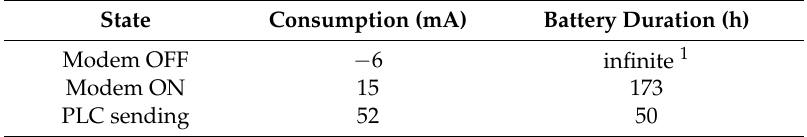
Table 4. Node consumptions while harvesting energy (current of 25 A through coupled power